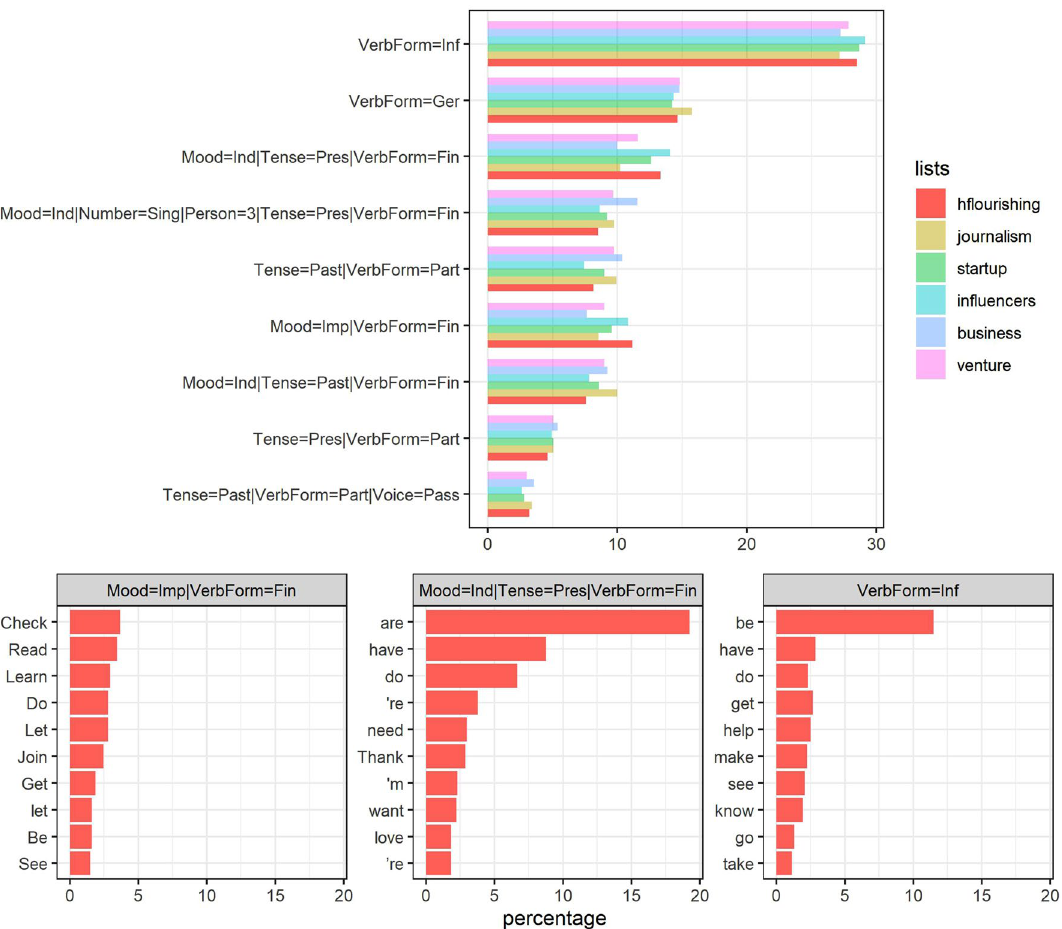
Figure 6. Above: percentages of the different verb tenses for each list. Below: the verb features in which the HF list is most prominent, showing which particular words are most frequent for each. Graphs were made by the authors, using R